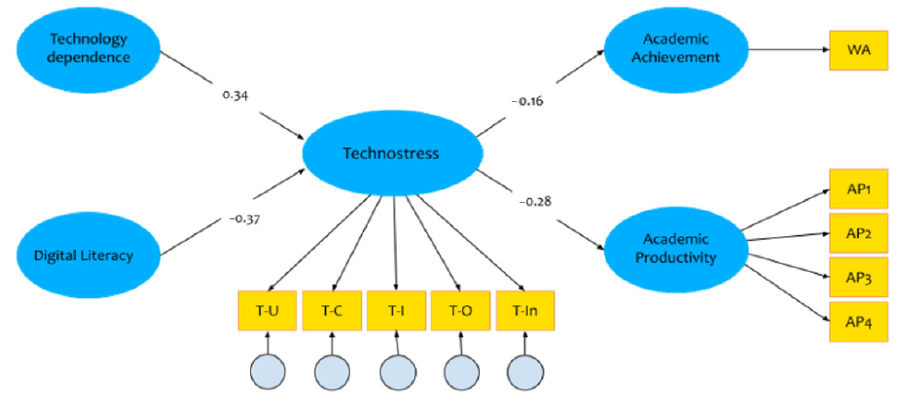
Figure 1. Structural model.